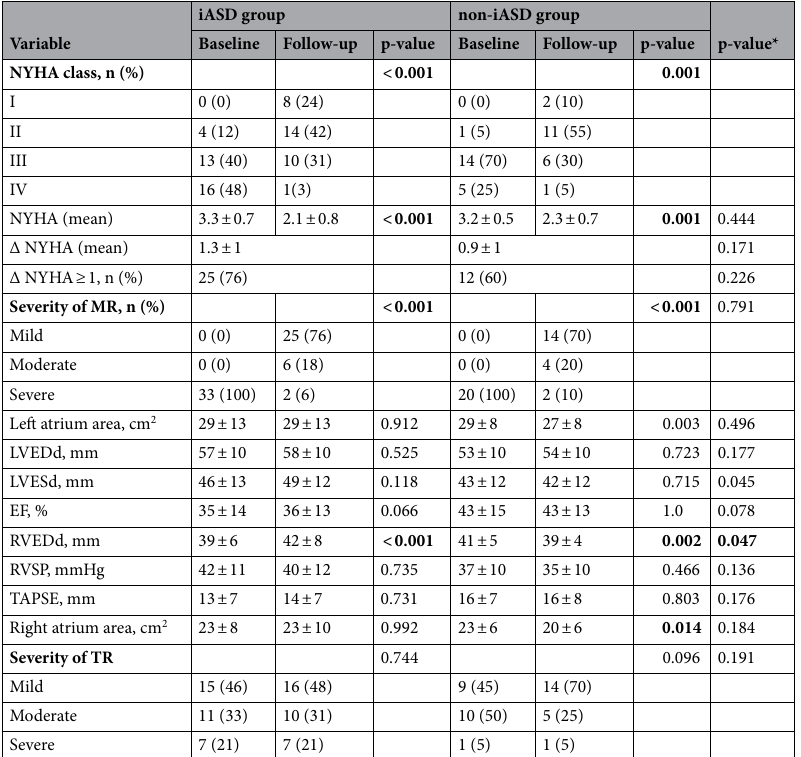
Table 3. Clinical and echocardiographic characteristics at baseline and at 6-month follow-up in patients with and without persistent iASD and comparison of follow up between both groups. *p-value for the comparison of outcome between the two groups at 6 months follow-up. NYHA New York Heart failure Association, Δ NYHA change of NYHA class before and after the procedure, Δ NYHA ≥ 1, n (%) Number of patients who met the defined clinical success of the procedure, MR mitral regurgitation, LVEDd Left Ventricle END Diastolic diameter, LVESd Left Ventricle End Systolic diameter, EF Ejection Fraction, RVEDd Right Ventricle End Diastolic diameter, RVSP Right Ventricle Pressure measured in echocardiography, TAPSE Tricuspid annular plane systolic excursion, TR Tricuspid